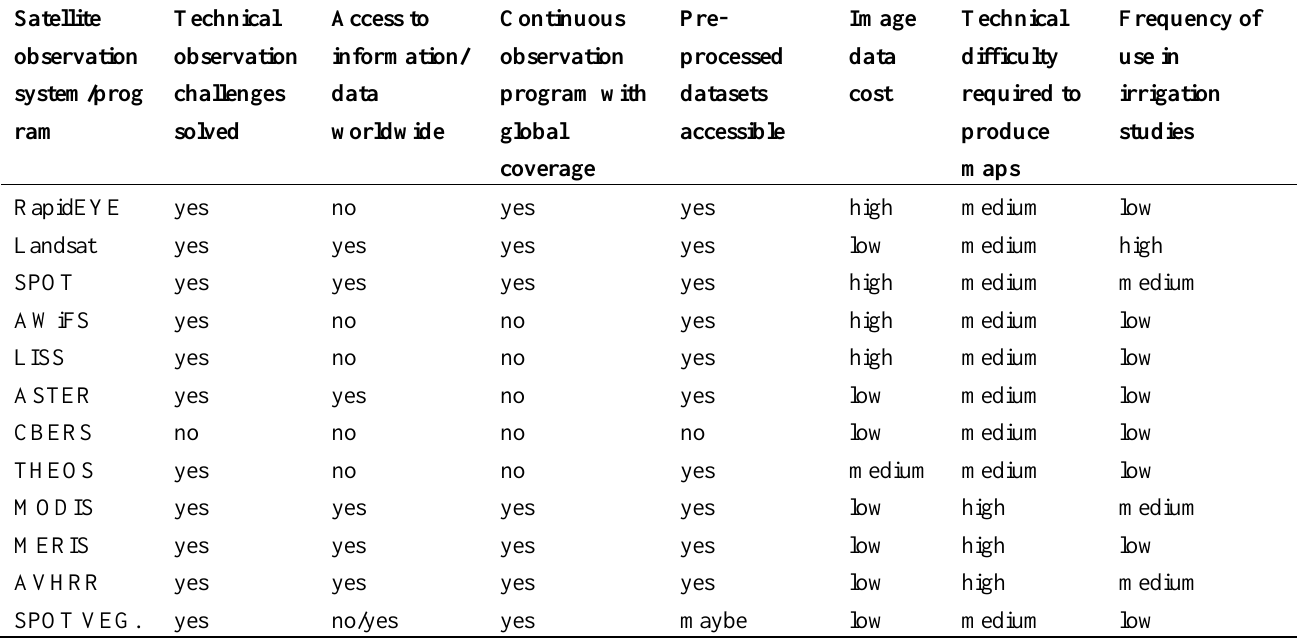
Table 1. Current operational optical sensors and their technical/logistical capacities for irrigation mapping. Some of the table headings are adapted from the United Nations Collaborative Programme on Reducing Emissions from Deforestation (UN-REDD) sourcebook and Forest Degradation in Developing Countries [97].